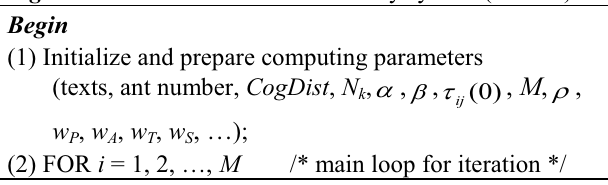
Algorithm-1 : The encounter ant colony system